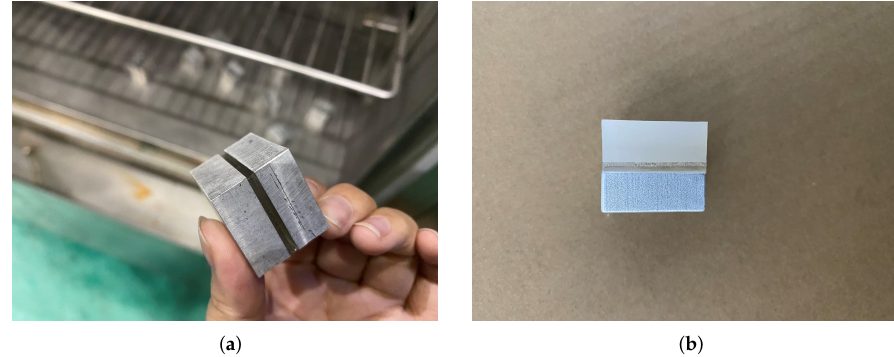
Figure 1. Ice diagram of specimens. ( a ) AL-Ice-AL specimen. ( b ) AL-Ice-SR